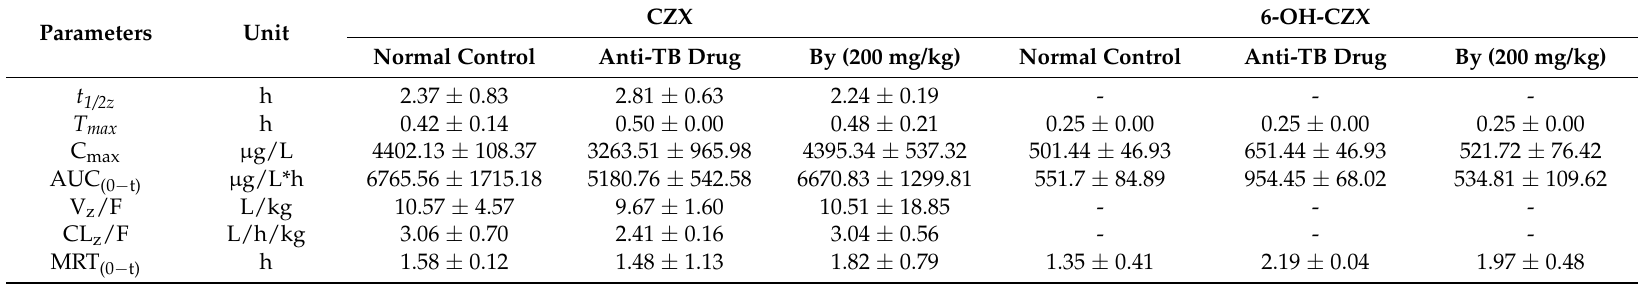
Table 2. Effects of bicyclol on the pharmacokinetics of CZX and 6-OH-CZX in anti-TB drug-intoxicated rats after oral administration of CZX at 20 mg/kg.